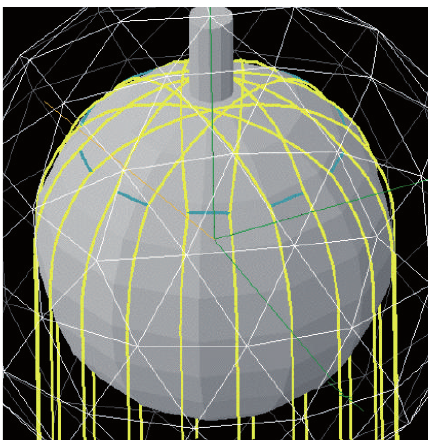
Figure 2: Sketch of the hold-down rope system on the top of the acrylic vessel to compensate for the buoyant force that the scintillator produces on the